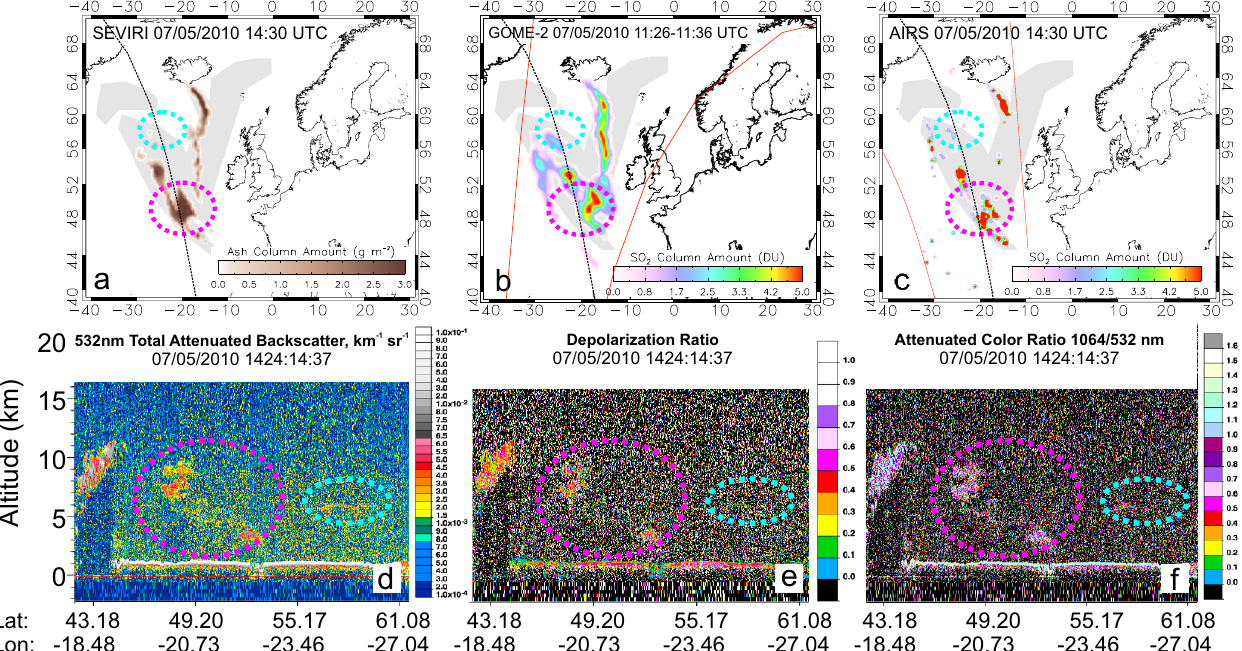
Fig. 5. Retrievals of ash and SO 2 for 7 May from SEVIRI, AIRS and OMI (a–c) as well as the coincident data from the CALIOP spaceborne lidar (d–f) . The pink and turquoise circles indicate where the lidar track crosses the cloud and the associated features visible in the lidar imagery. The dashed black line defines the ground track of the lidar. As before the red dashed lines indicate the swath edge of the polar orbiting instruments and the grey lines delimit the OMI row anomaly, between which no useable data are acquired.